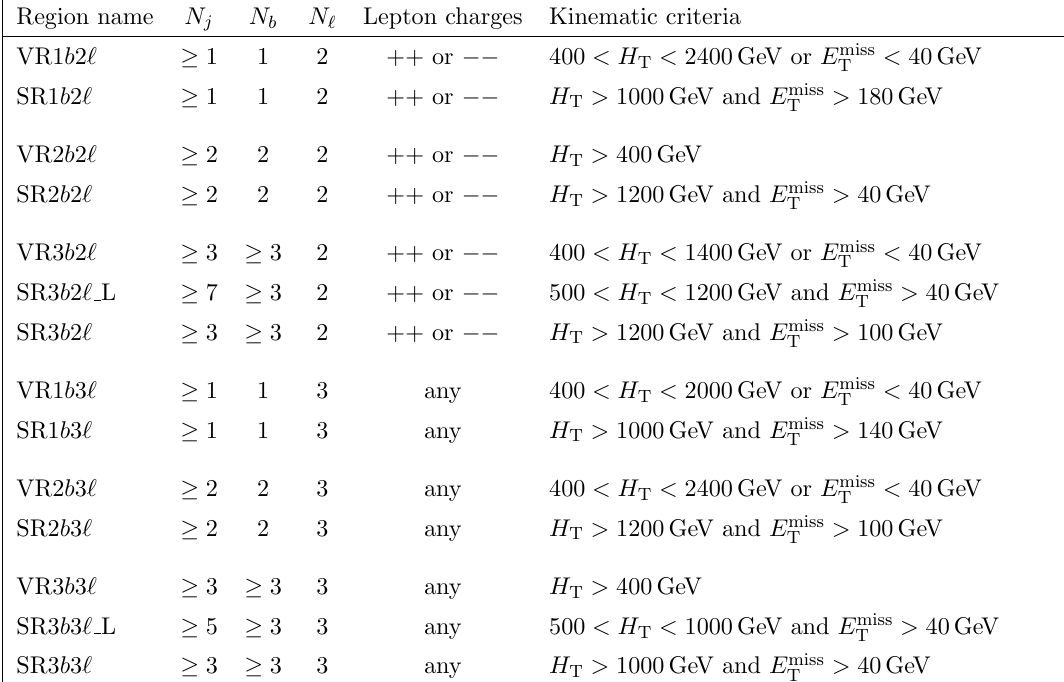
Table 2 . De(cid:12)nitions of the validation and corresponding signal regions for the four-top-quark and VLQ searches, where N j is the number of jets, N b is the number of b -tagged jets, and N ‘ is the number of leptons. The name of each signal (validation) region begins with \SR" (\VR"), with the rest of the name indicating the number of leptons and number of b -tagged jets required. The su(cid:14)x \ L" denotes the signal regions with relaxed H T but stricter N j requirements. For regions that require two leptons, the leptons must have the same charge. Events that appear in any of the signal regions are vetoed in the validation